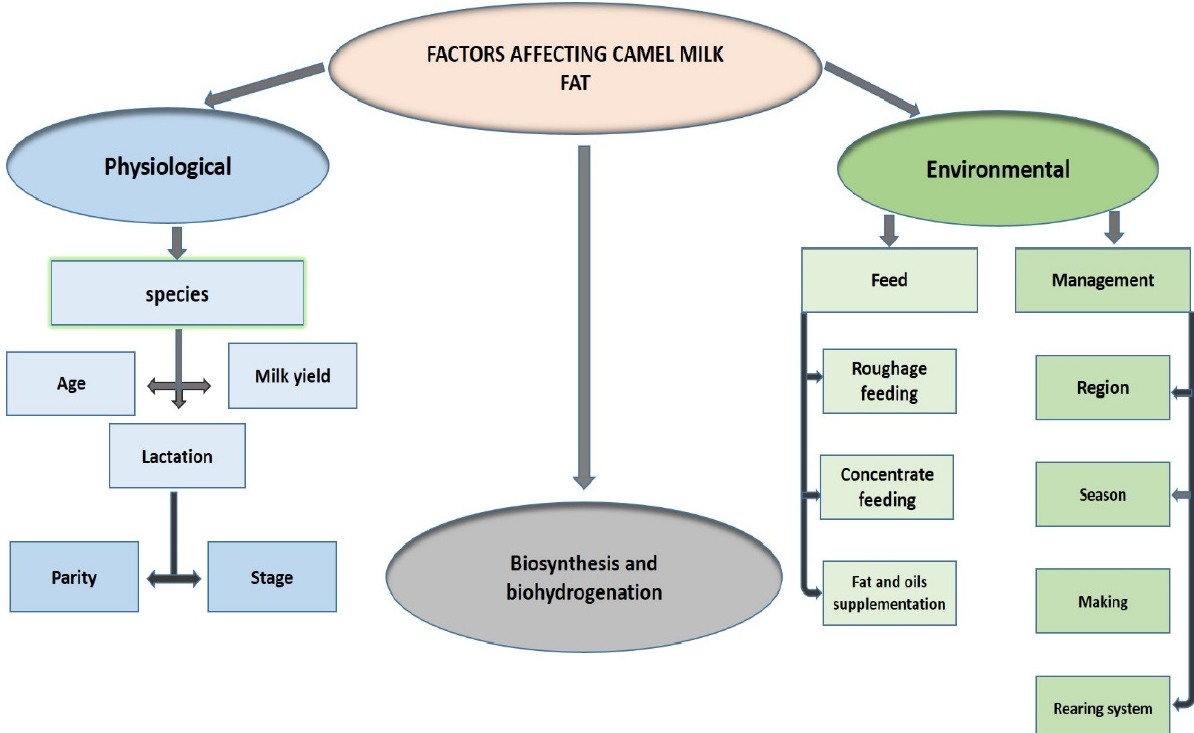
Figure 5. Factors affecting camel milk fat composition. SFAs and PUFAs constitute 60.60% and 4.80% of overall FAs, respectively, in C. bac- trianus milk fat, which is higher than SFAs (56.03%) and PUFAs (4.20%) in C. dromedarius milk fat. While C. dromedarius milk fat contains more MUFAs (36.70%) than C. bactrianus CM fat (31.40%), as reported by Zhao et al. [103]. The FA composition was studied with- out taking into account the variations due to seasonal conditions in the majority of the literature data [11,12,14,15,18,20,54,68,88,97,102,104], suggesting that this aspect should be considered in the future. Yet, short-chain FAs (C8:0 and C10:0) were found to be